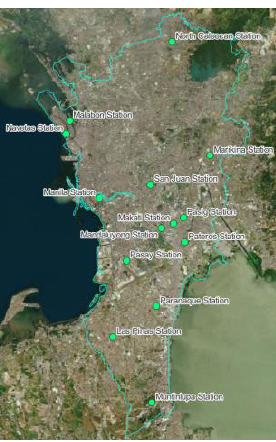
Figure 3. Air quality monitoring stations in the NCR.